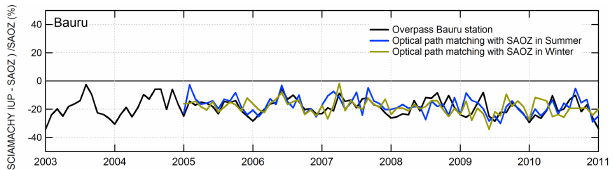
Figure A1. NO 2 percent mean difference between SCIAMACHY IUP and SAOZ over Bauru. SCIAMACHY overpass in black, Opti- cal path matching in the solstice summer in blue and in the solstice winter in green.